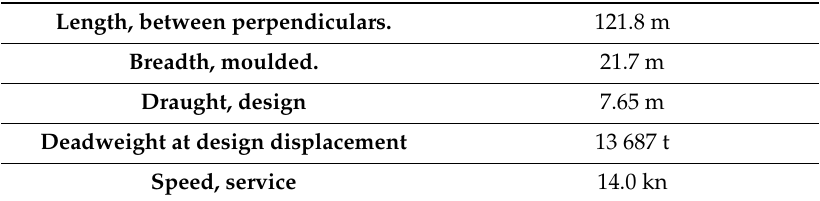
Table 1. The main dimensions of the ship. Length, between perpendiculars.